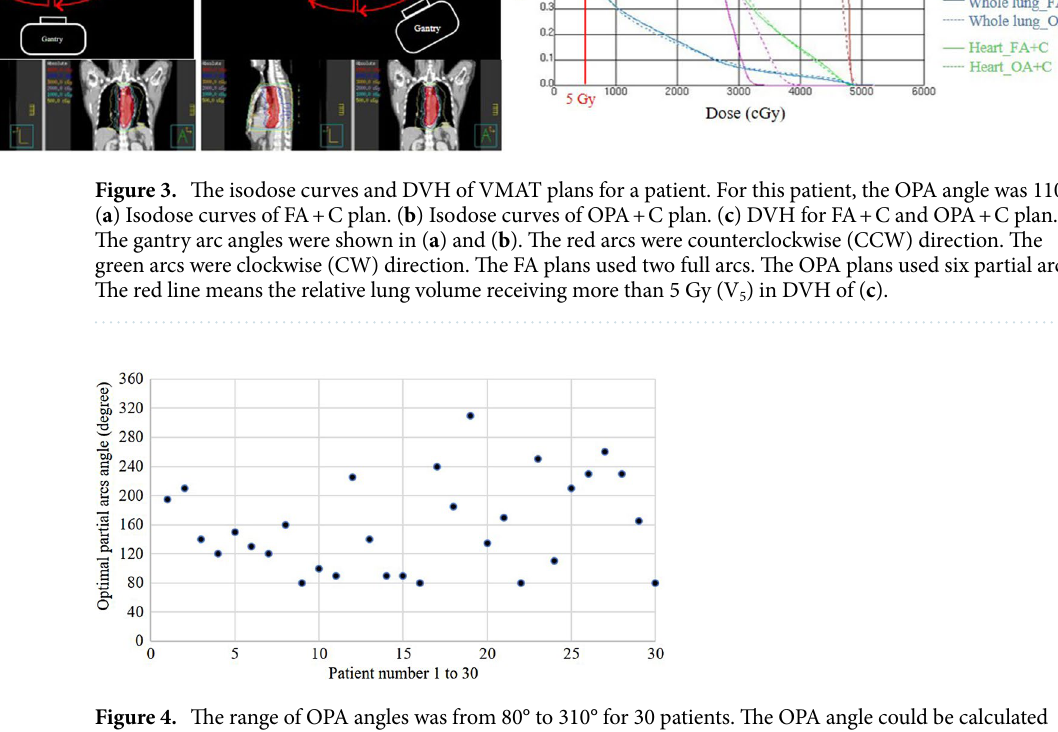
Figure 4. The range of OPA angles was from 80° to 310° for 30 patients. The OPA angle could be calculated using VBA for each